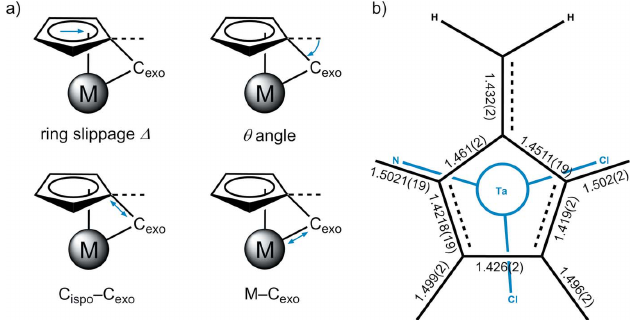
Figure 3 ( a ) A view along the b axis showing the packing of molecule pairs of 2 interacting via C—H (cid:2)(cid:2)(cid:2) Cl hydrogen bonds. ( b ) Double chains of 2 formed by (cid:3) – (cid:3) stacking and H (cid:2)(cid:2)(cid:2) (cid:3) interactions. Color code: C dark gray, H white, Cl green, N blue, Ta light gray.